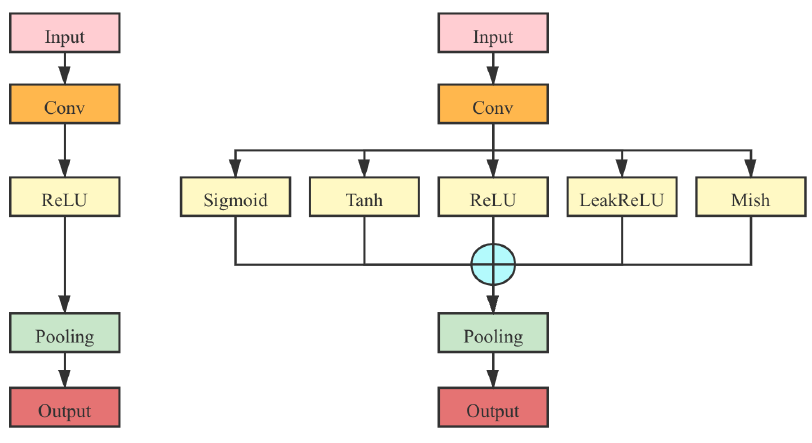
Figure 9. MAF module applied to the VGG series (the original one is on the left; the optimized one is on the